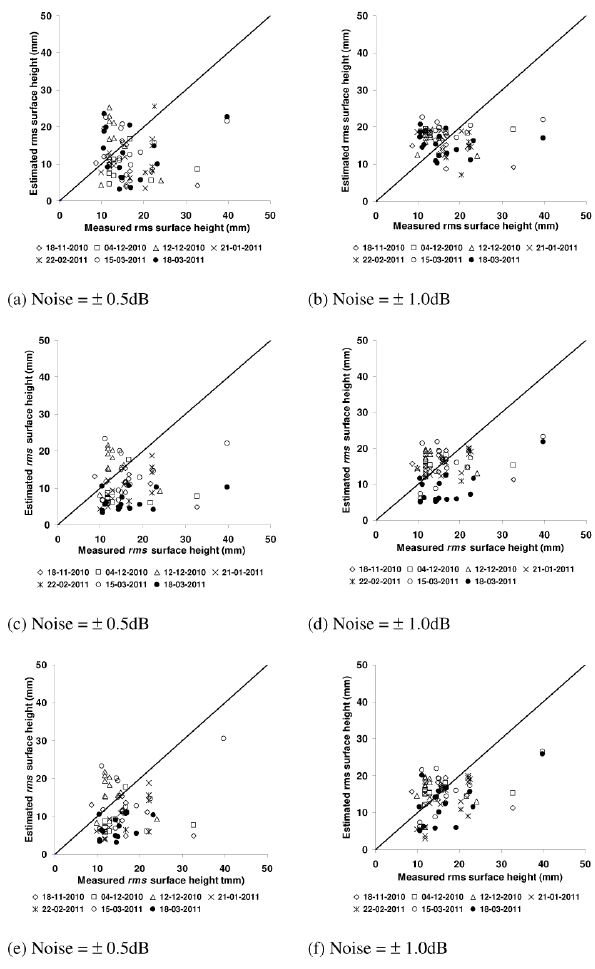
Fig. 5. Retrieved rms surface height versus in situ